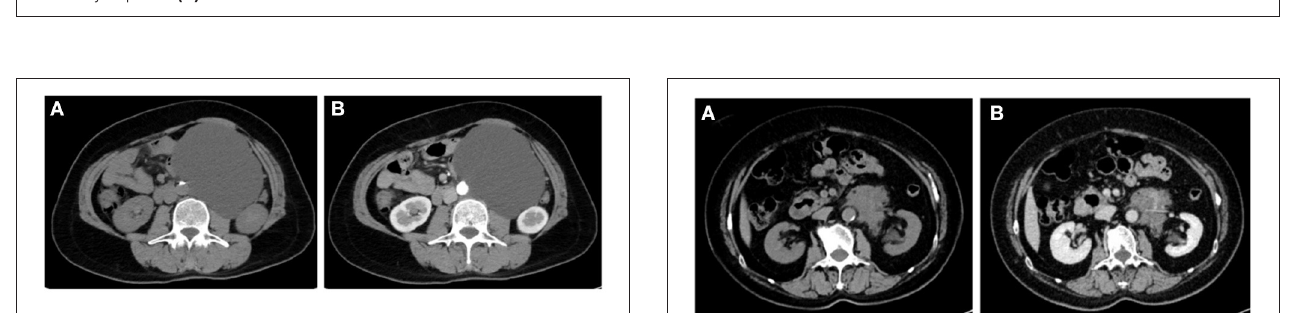
FIGURE 3 | CT showed an irregular retroperitoneal mass of mixed density with coarse margin between the abdominal aorta and the left renal hilum in plain CT (A) . The mass was shown as heterogeneous enhancement in the delayed phase (B) .